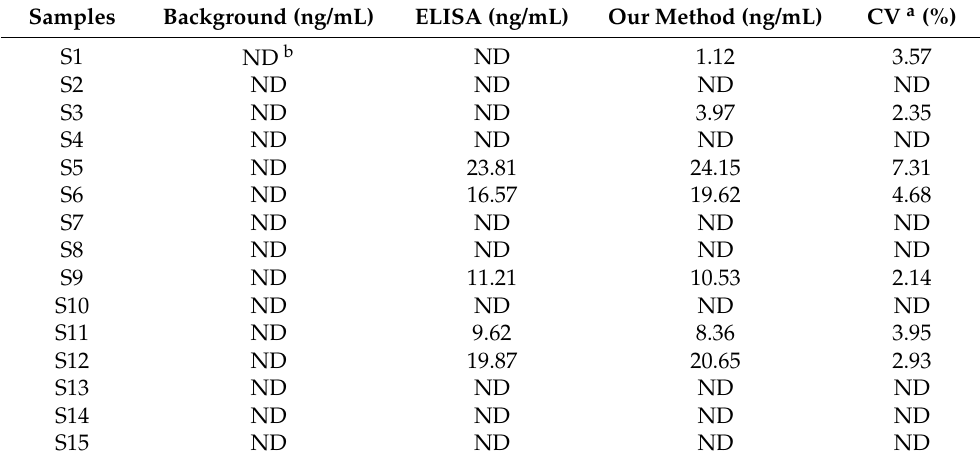
Table 2. Comparison of DBP detection using our established method and the conventional ELISA ( n = 3). Samples